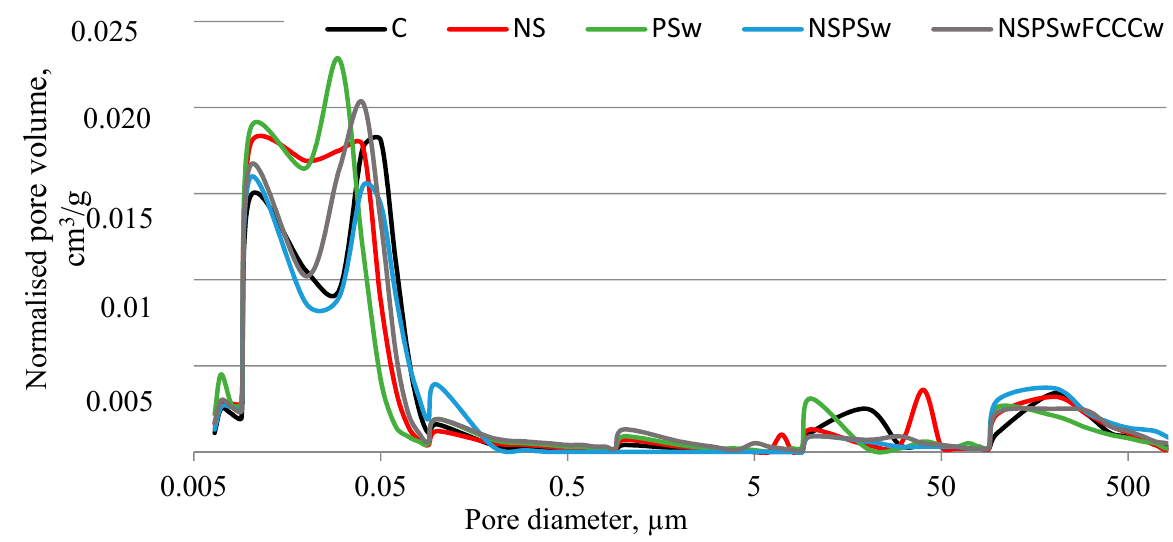
Figure 9. Results of normalized pore volume in hardened cement paste.